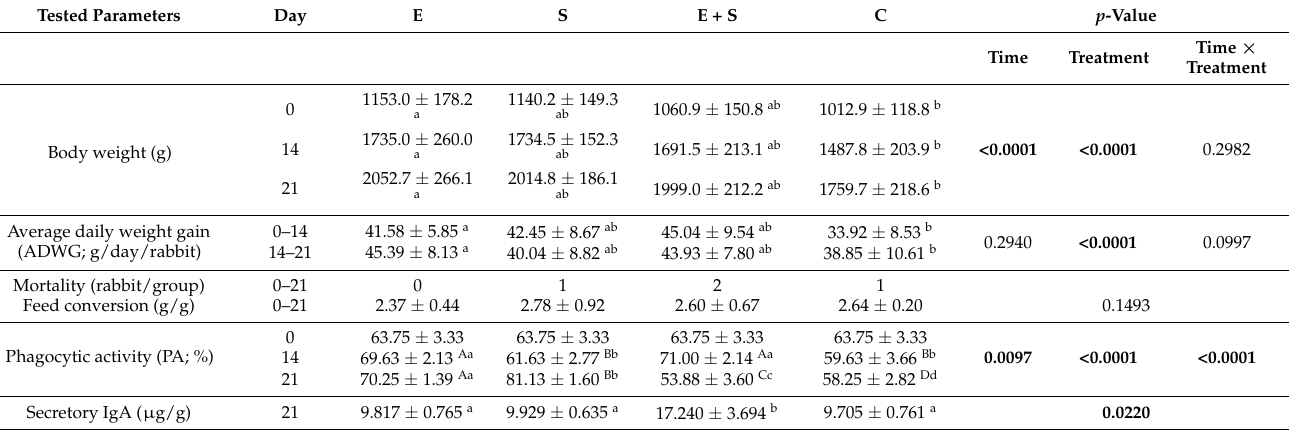
Table 2. Growth performance, phagocytic activity, and secretory IgA of